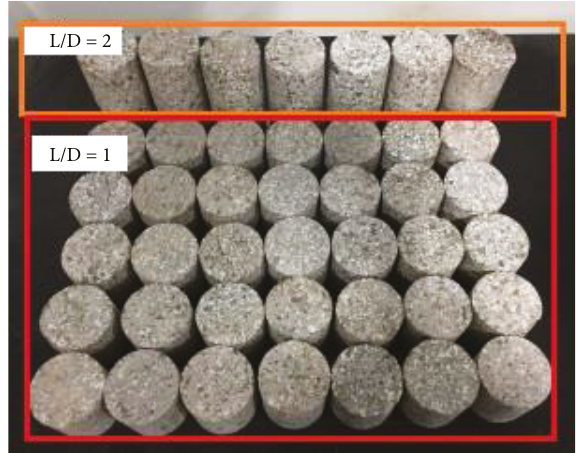
Figure 1: Processed weakly weathered granite specimens [23]. “ The fi gure is reproduced from Yan et al. [23] (under the Creative Commons Attribution License/public domain).